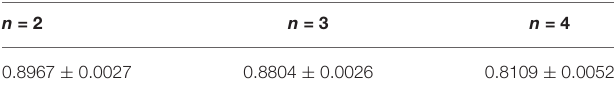
TABLE 1 | AUCs achieved by BWNMHMDA in the framework of 5-Fold CV while n = 2, 3, 4 separately. n = 2 n = 3 n = 4 0.8967 ± 0.0027 0.8804 ± 0.0026 0.8109 ±